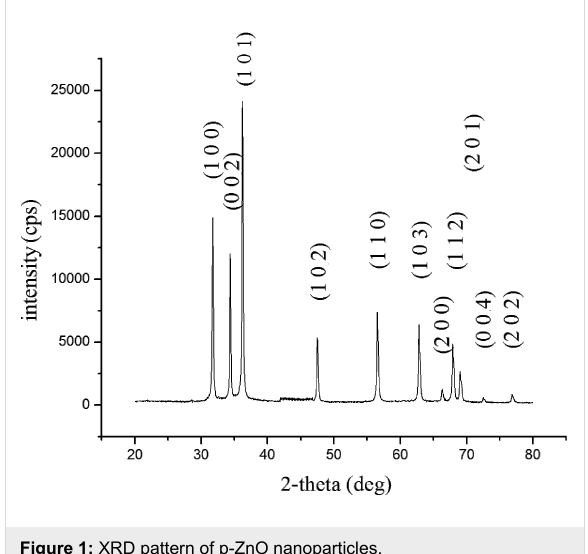
Figure 1: XRD pattern of p-ZnO